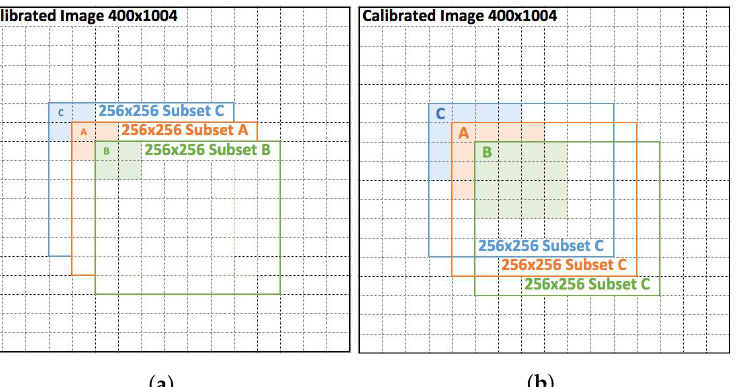
Figure 6. Illustration of the sequence generation. On ( a ) colored areas represent the target for 2 × 2 average pooling on each of the subsets that will create the 2D sub-pixel motion in the HR image sequence. On ( b ) colored areas represent the target 4 × 4 average pooling instead. Sequence B has a motion vector (1,1) with respect to A, and (2,2) with respect to